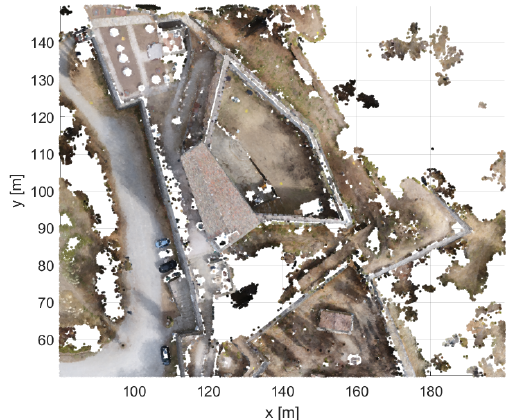
Figure 5. Top view of the point cloud generated by Agisoft Pho- toscan after vegetation removal.